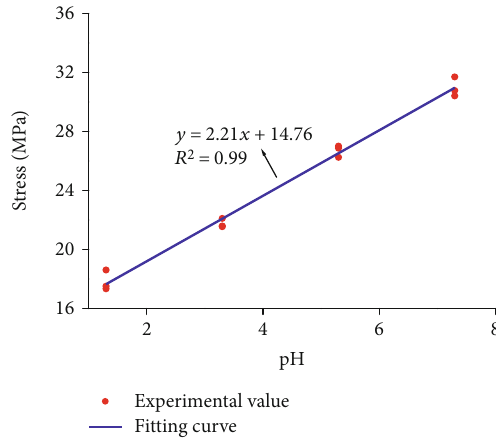
Figure 5: Variation trend of peak stress with